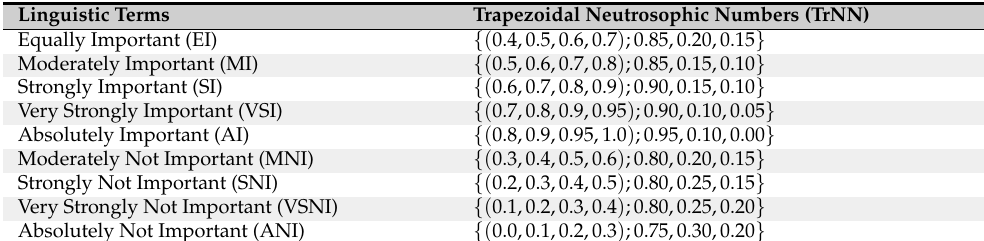
Table 9. Linguistic terms and their corresponding TrNN.